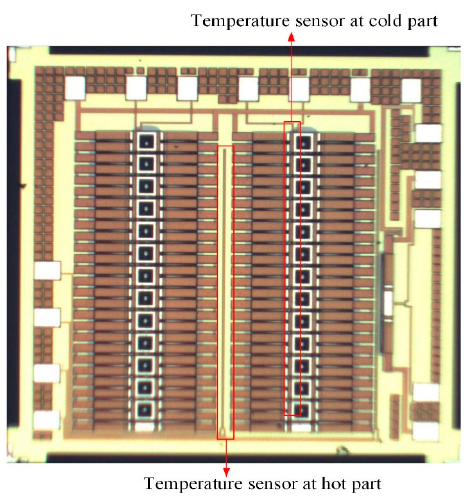
Figure 10. The TEMH taken by optical microscope.